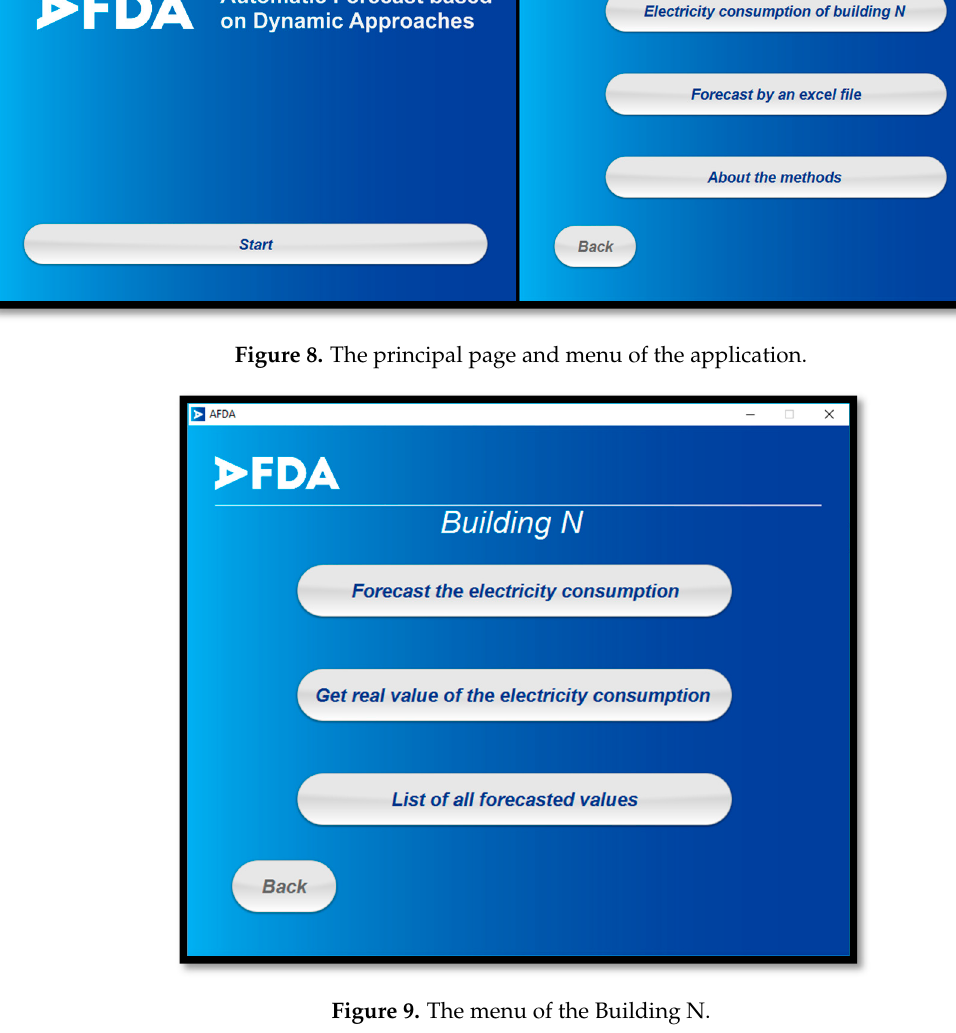
Figure 9. The menu of the Building N.